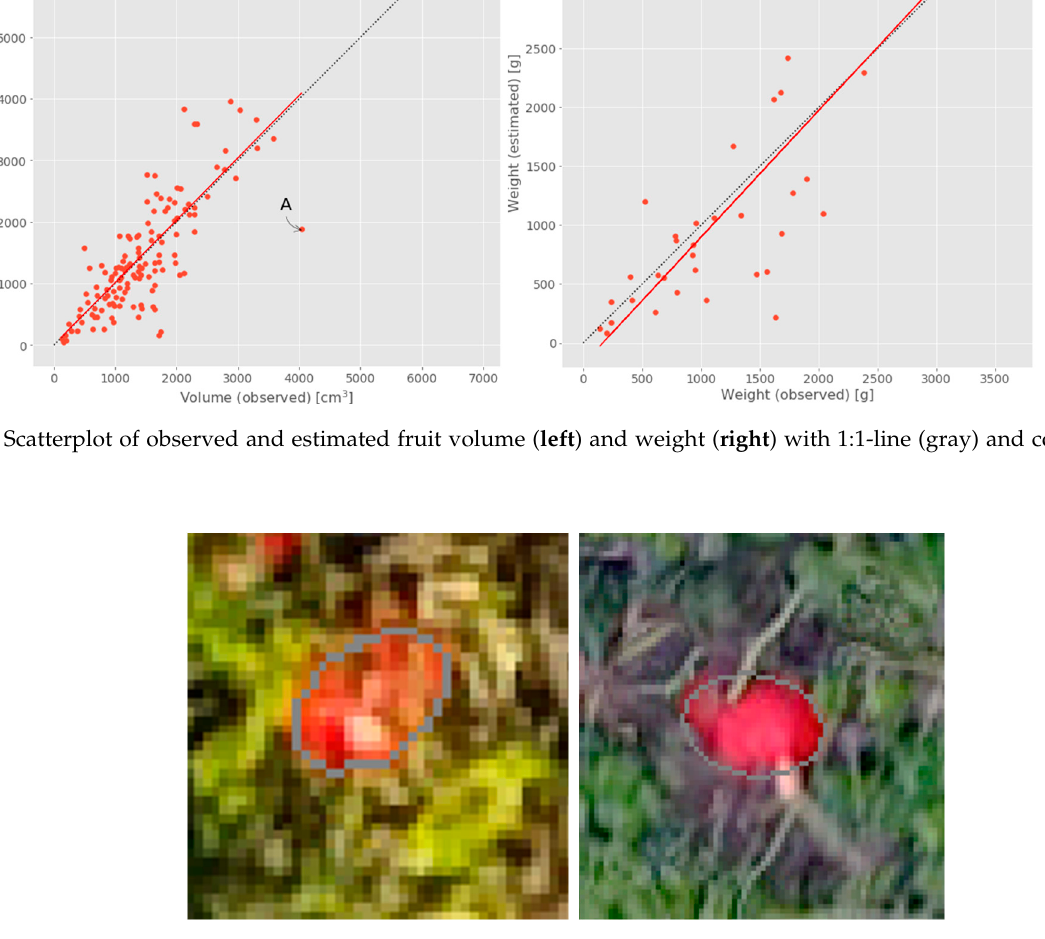
Table 3. Distribution of Hokkaido fruits within the weight classes for food retailing. Weight Class (kg).